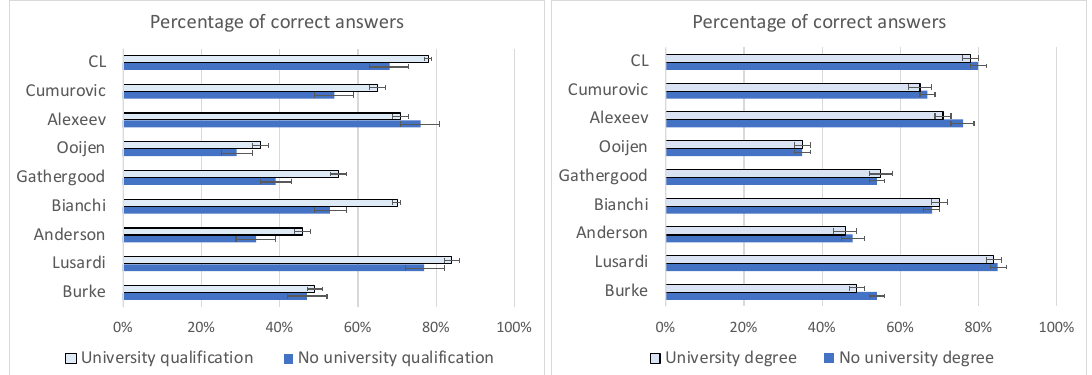
Figure A1. Effects of education on financial literacy measures. For most (but not all) measures in our sample, a university qualification (in Germany, this corresponds usually to an “Abitur”) increases financial literacy, but a university degree does not.